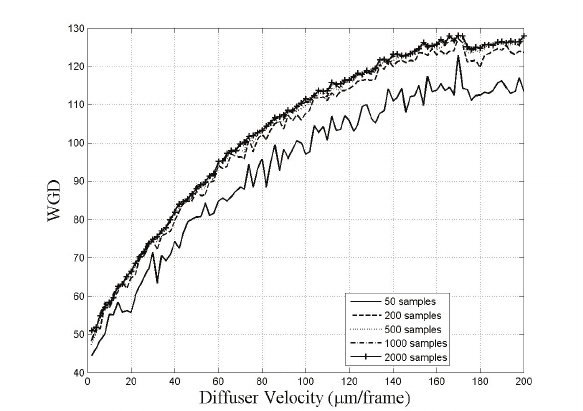
Fig. 13 Weighted Generalized Differences descriptor ( WGD )